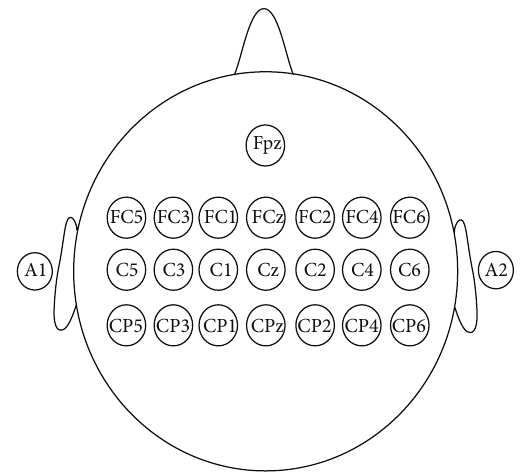
Figure 2: The electrodes used in the